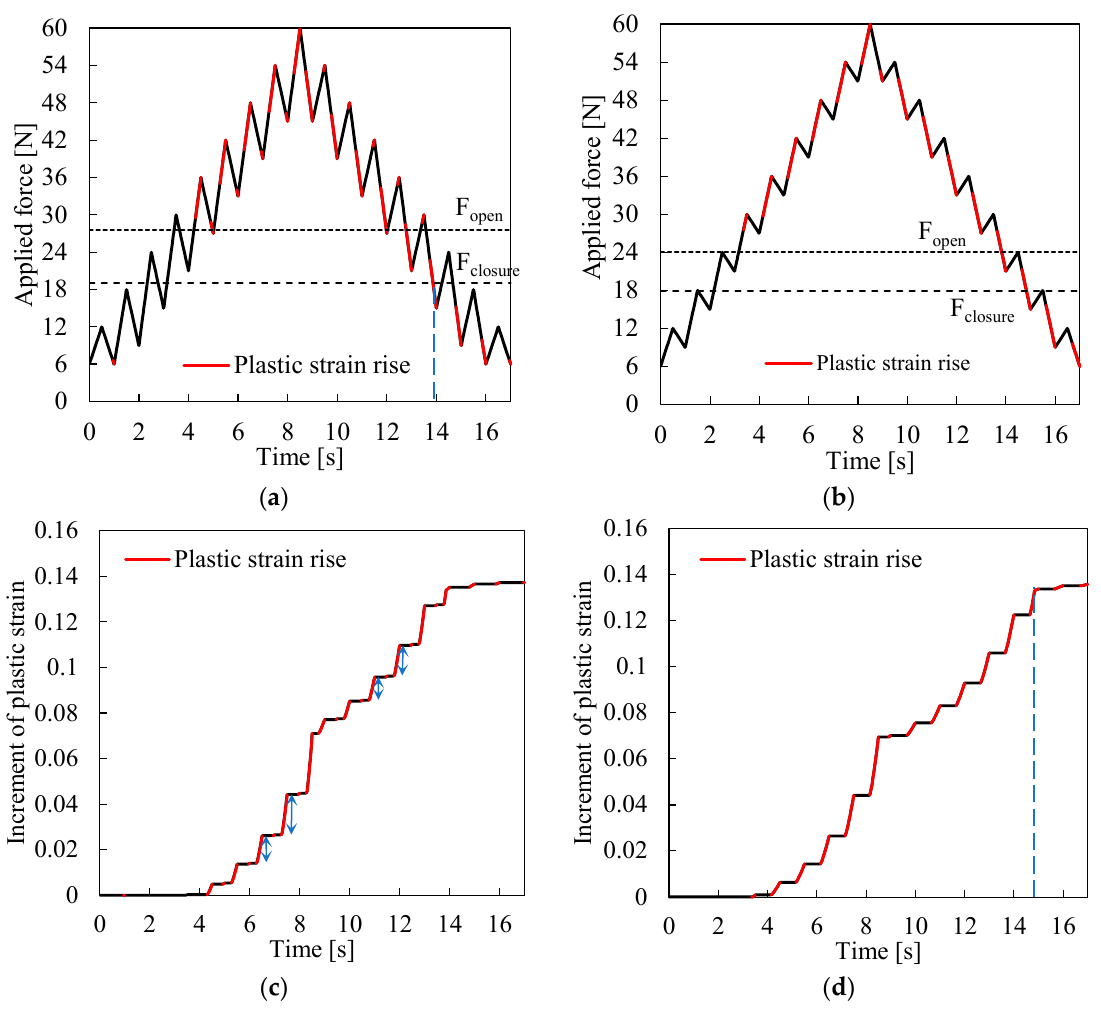
Figure 7 . Evolution of plastic deformation during loading to a = 15.30 mm: ( a ) Christmas Tree (15–9) pattern; ( b ) Christmas Tree (9–3) pattern; ( c ) plastic strain rise of Christmas Tree (15–9) pattern; ( d ) plastic strain rise of Christmas Tree (9–3) pattern.